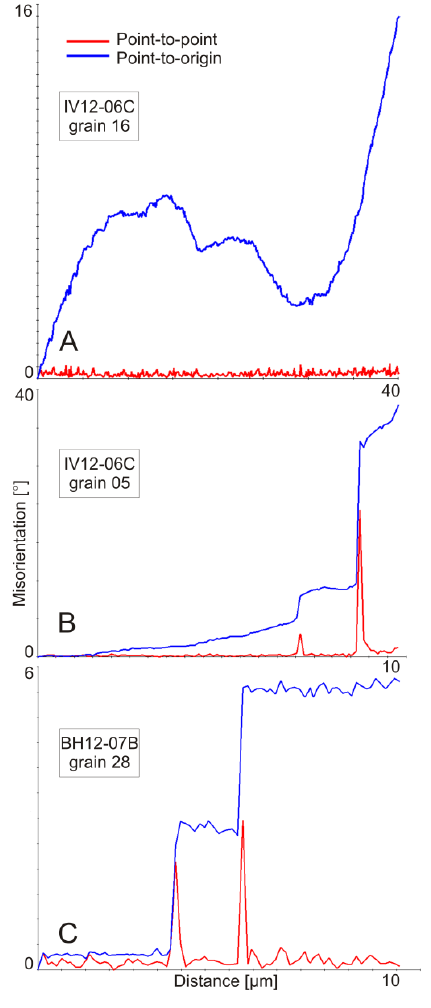
Figure 13. Misorientation profiles of zircon showing point-to- point (red line) and point-to-origin (blue line) misorientations for (a) grain IV12-06C_16, displaying spatially continuous lattice rota- tion (for location of the profile line see Fig. 12a). (b) Grain IV12- 06C_05, showing subgrain boundary formation together with spa- tially continuous lattice distortion (for location of the profile line see Fig. 10a). (c) Grain BH12-07B_28, exhibiting subgrain forma- tion (for location of the profile line see Fig.